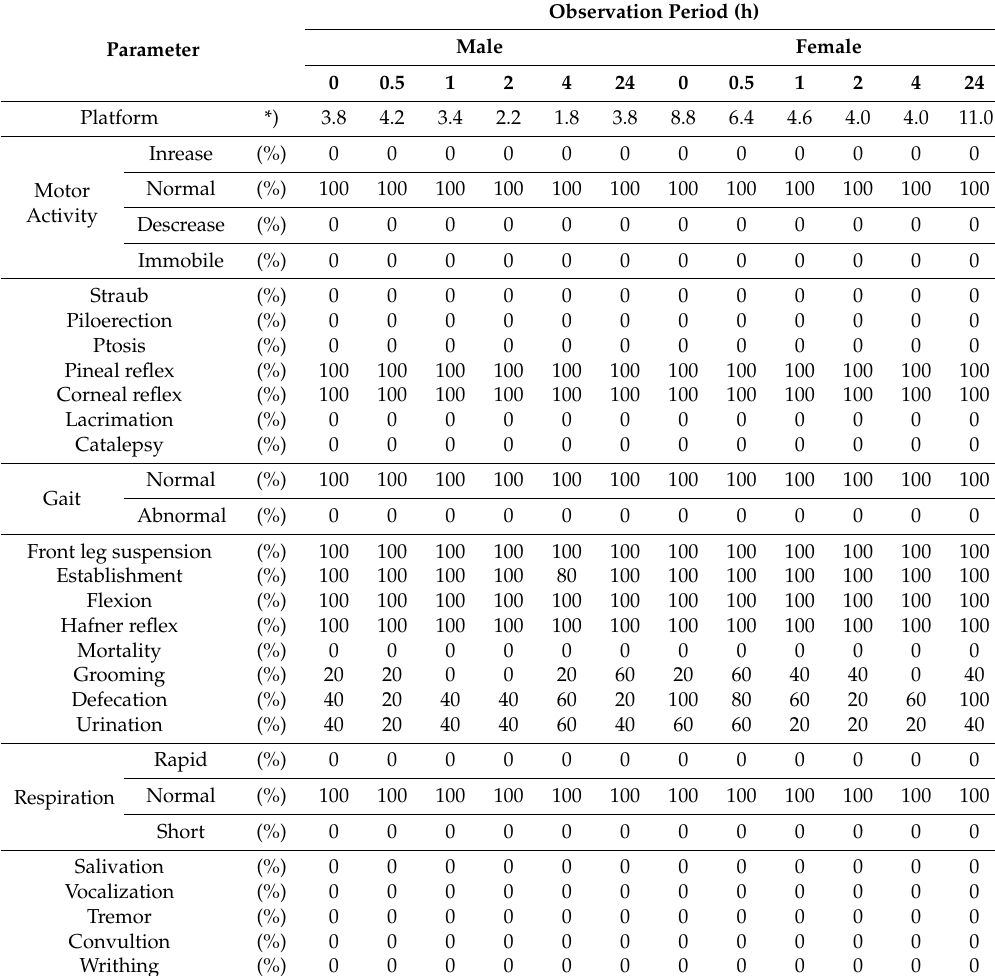
Table 2. Effects of the test substance on behavior following its single-high dose administration. A single dose of 5000 mg/kg was given to five mice of both sexes, followed by behavioral examination during a 24 h observation